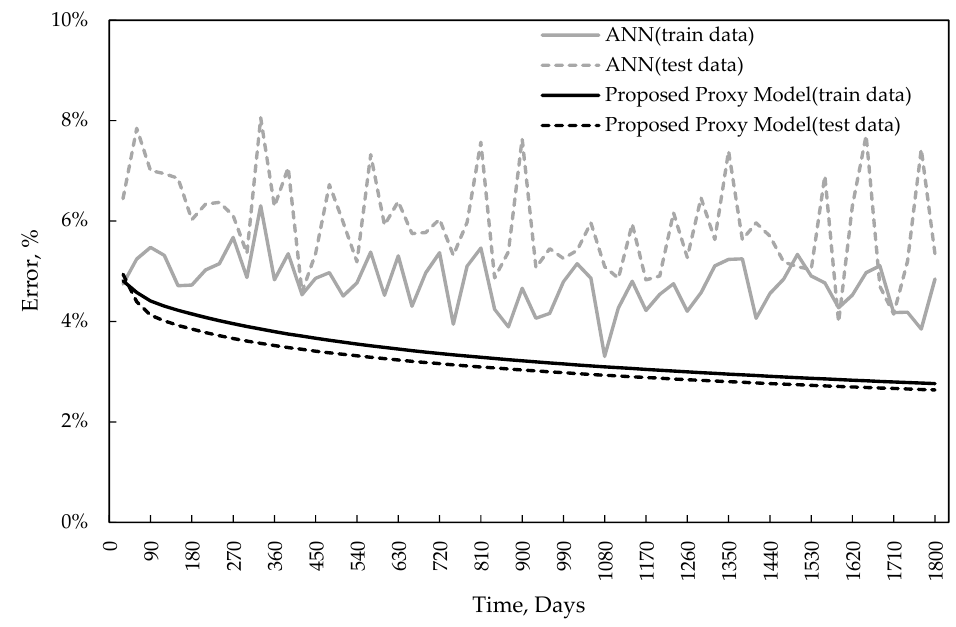
Figure 7. Cross plot of cumulative gas productions at each proxy model.